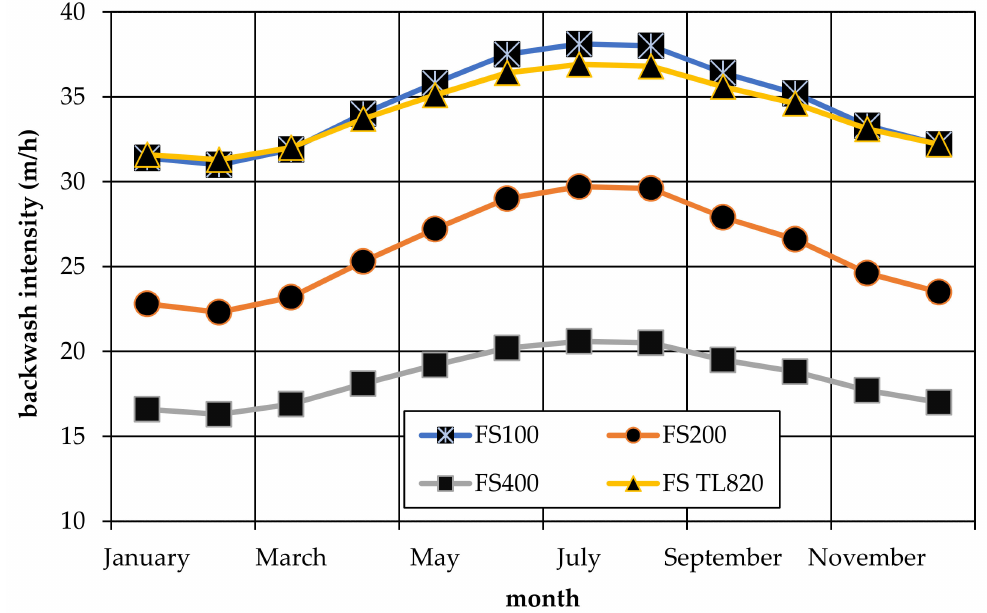
Figure 8. Backwash intensities of different GAC types at 25% expansion and average monthly water temperatures.